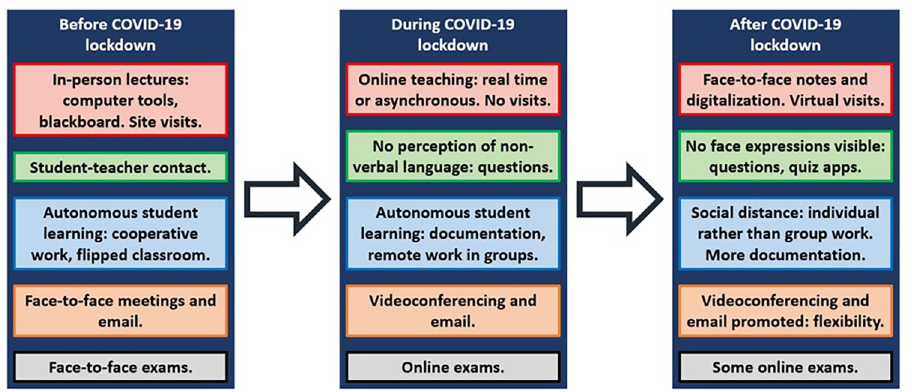
Fig 2. Overview of civil-engineering teaching during COVID-19